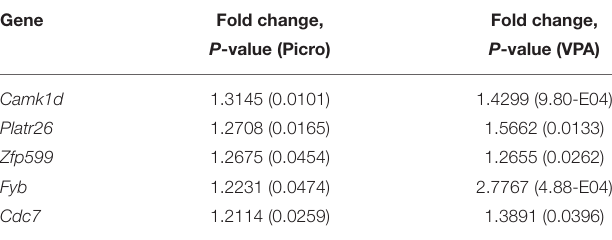
TABLE 3 | Genes whose expression was altered in picrotoxin-exposed and VPA-exposed mice. Gene Fold change, Fold